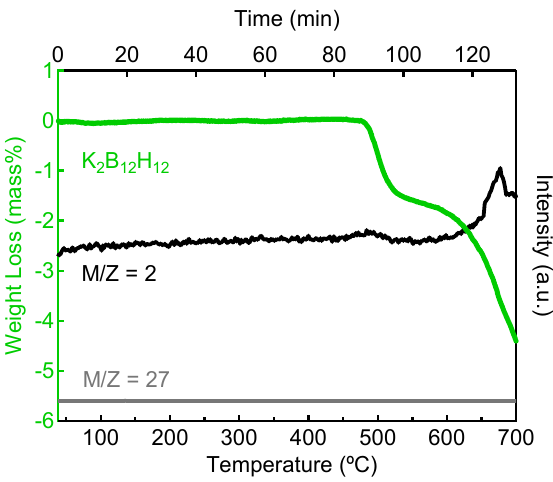
Figure 7. TG curve and MS signals of anhydrous K 2 B 12 H 12 (mass numbers 2 and 27 represent H 2 and B 2 H 6 ).